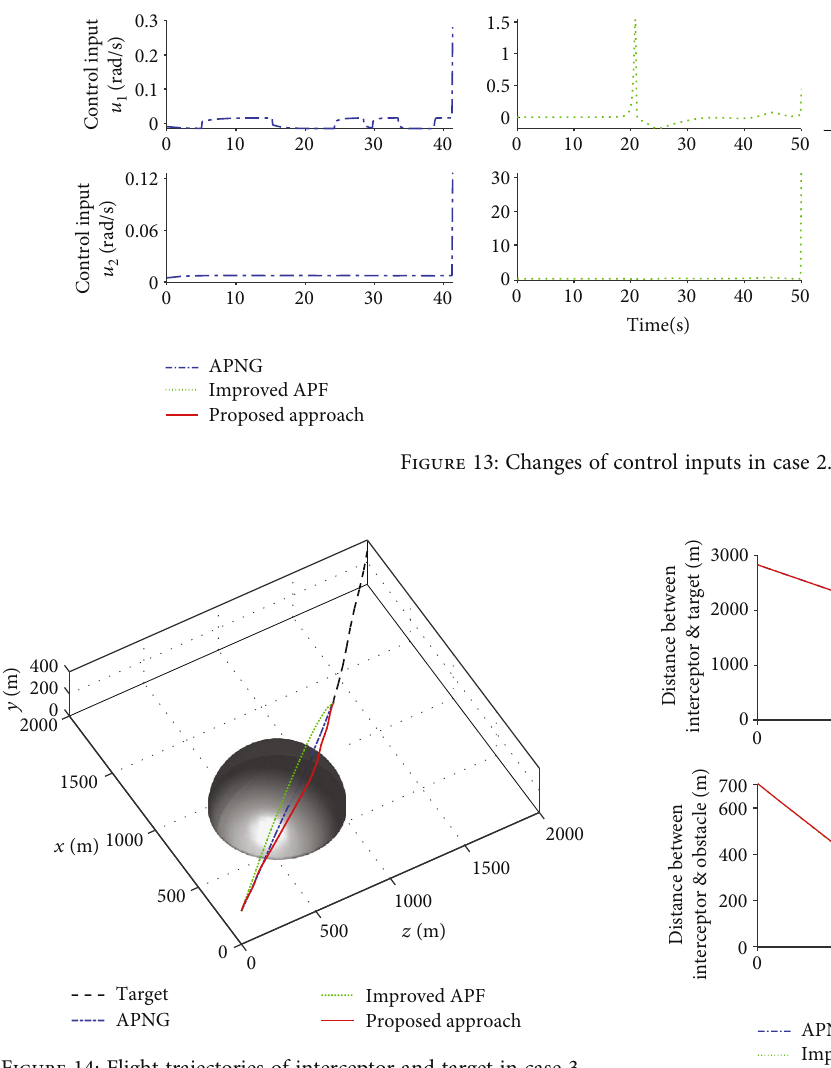
Figure 14: Flight trajectories of interceptor and target in case 3.